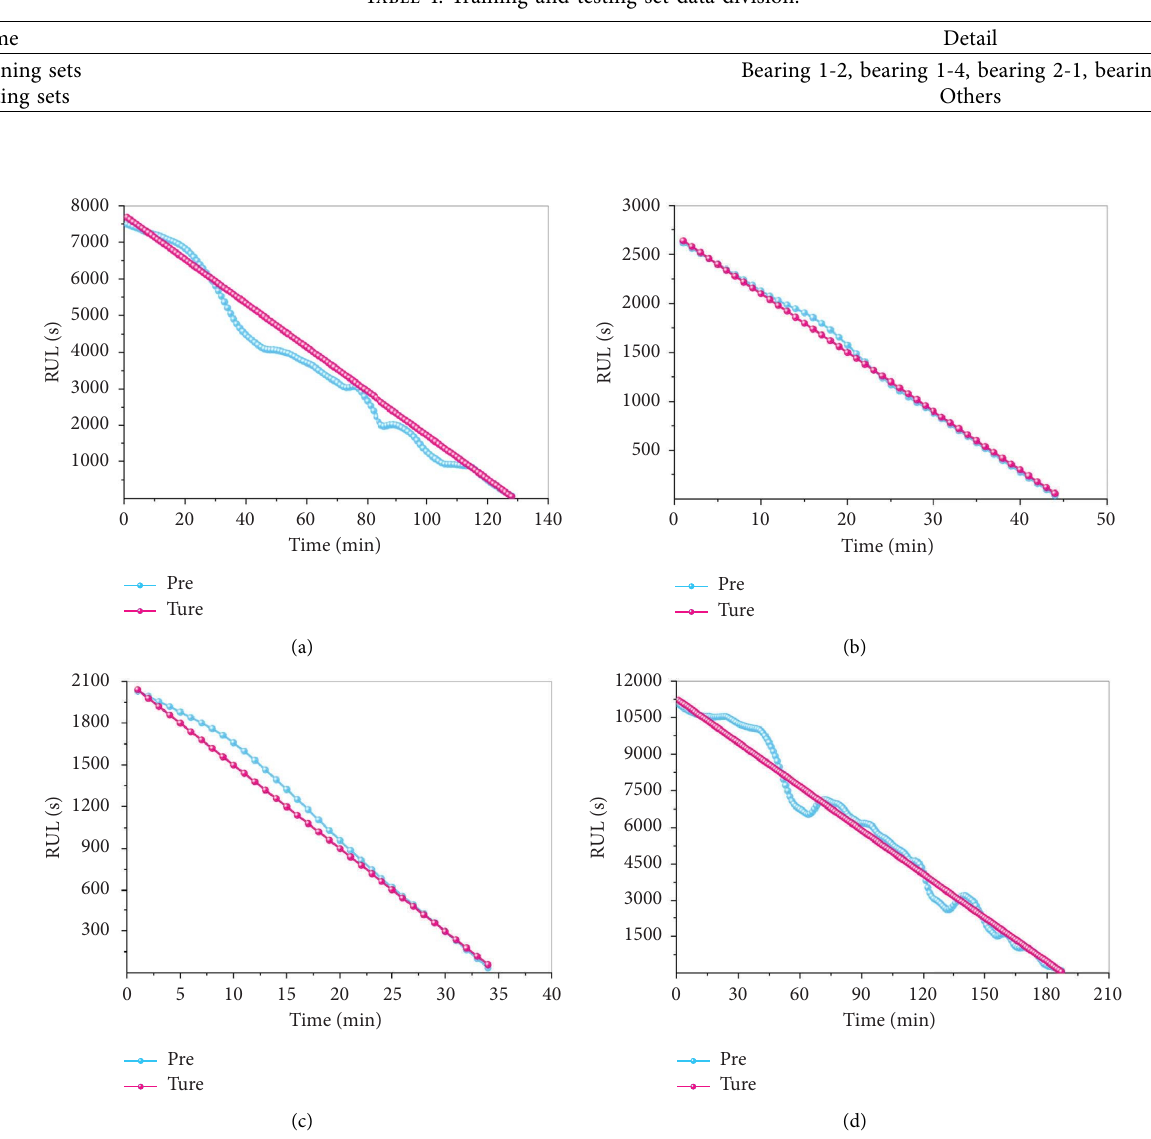
Figure 10: DELSTM training set training results. (a) Bearing 1-2. (b) Bearing 1-4. (c) Bearing 2-1. (d) Bearing